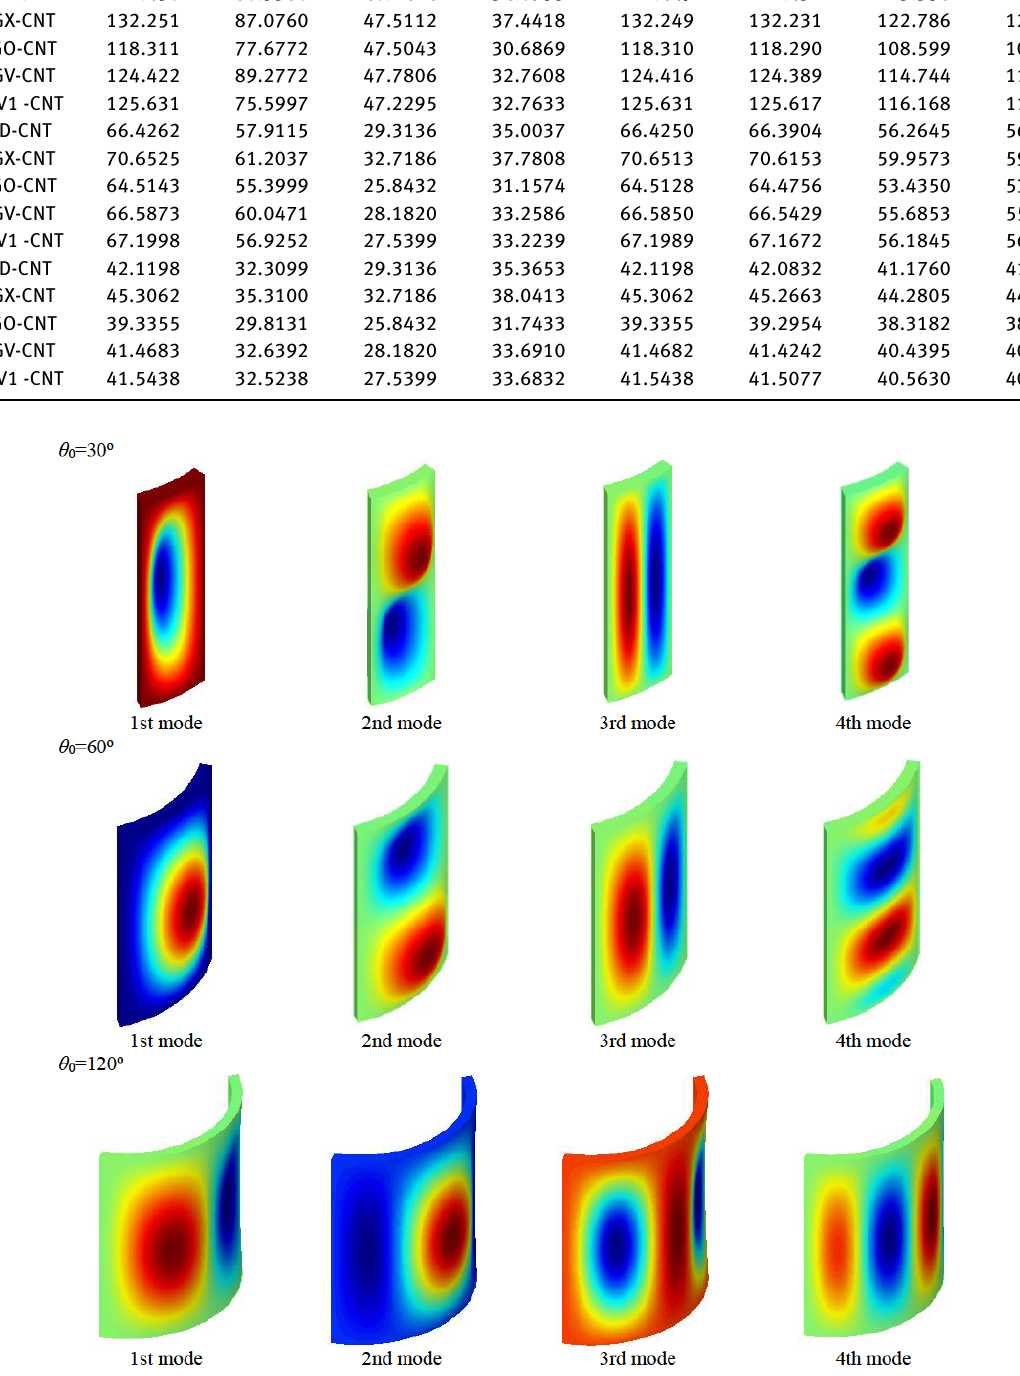
Figure 7: Mode shapes of the E 3 E 3 E 3 E 3 FG-CNT reinforced composite panel with FGV-CNT type and volume fraction V tcnt